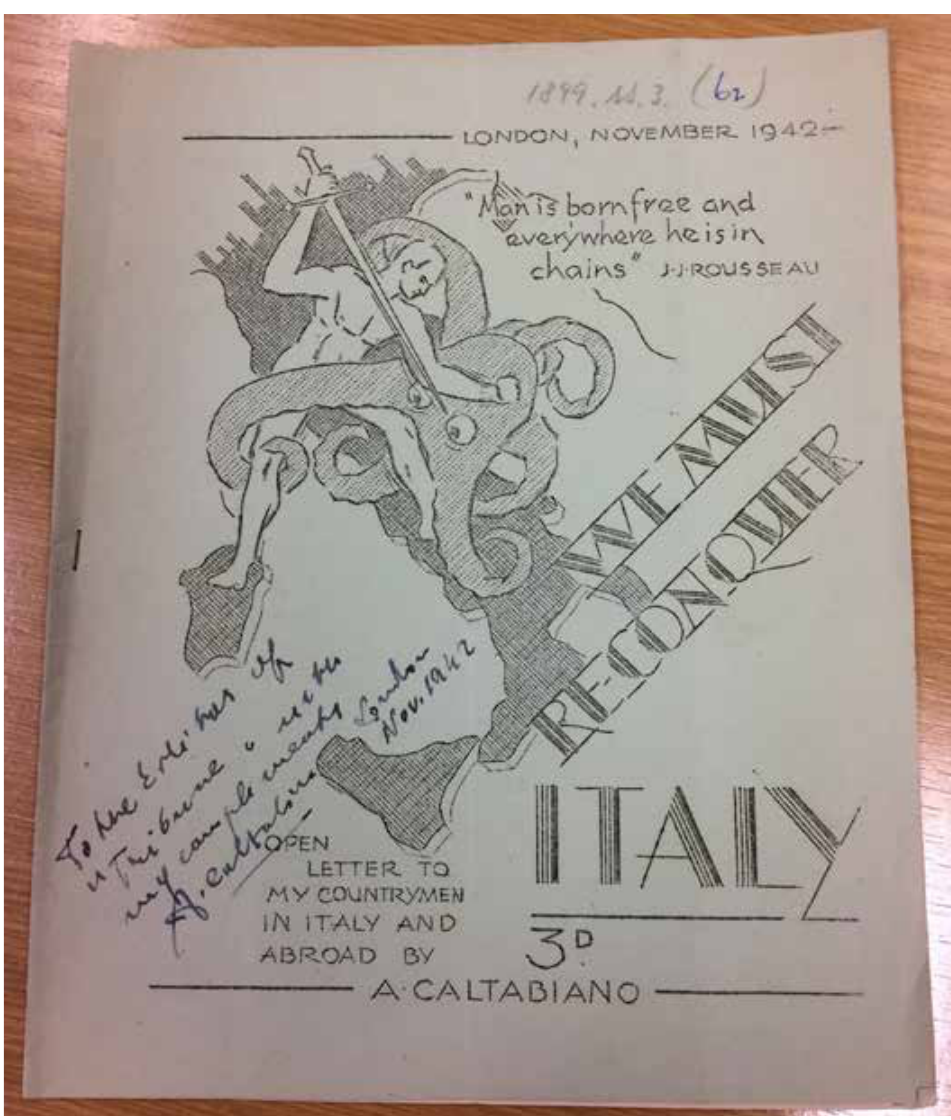
Fig 1. Cover of A. Caltabiano, We Must Reconquer Italy: Open Letter to my Countrymen in Italy and Abroad (London, 1942). BL, 1899.ss.3.(62.)